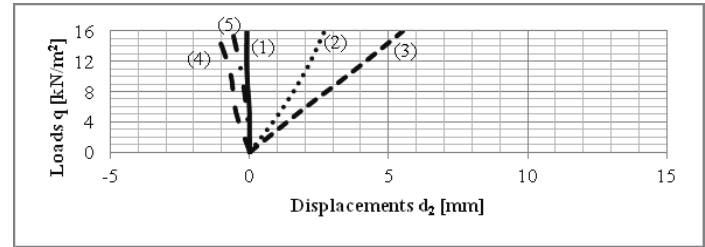
Fig. 7c. Displacements d 2 (mm) depending on the use of sheet piles as a cover of the foundation. Horizontal load applied on the backfill of road embankment